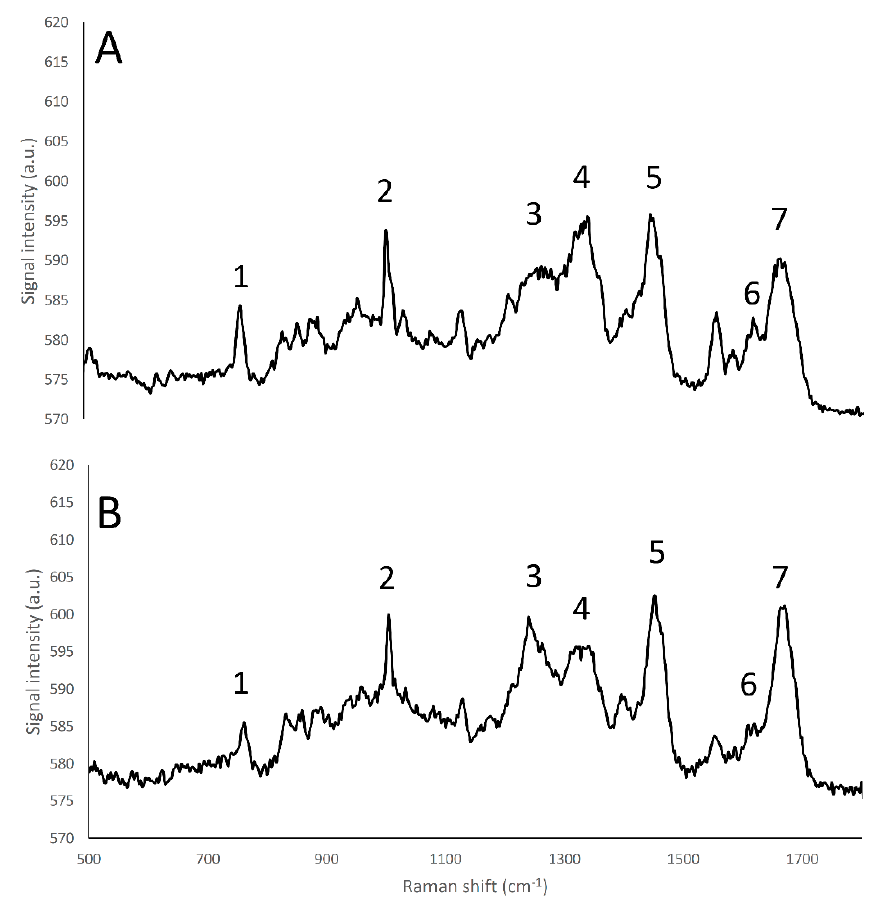
Figure 3. Raman fingerprint region (500–1800 cm − 1 ) of α -lactalbumin ( A ), and β -lactoglobulin ( B ). (1) tryptophan indole ring (750–760 cm − 1 ); (2) Phenylalanine benzene ring breathing (1000–1005 cm − 1 ); (3) amide III β -sheet structure (1270 cm − 1 ); (4) amide α -helices structure (1320–1340 cm − 1 ); (5) CH 2 bend peak (1450 cm − 1 ); (6) tyrosine (1614 cm − 1 ); (7) amide I (1650–1670 cm − 1 ).